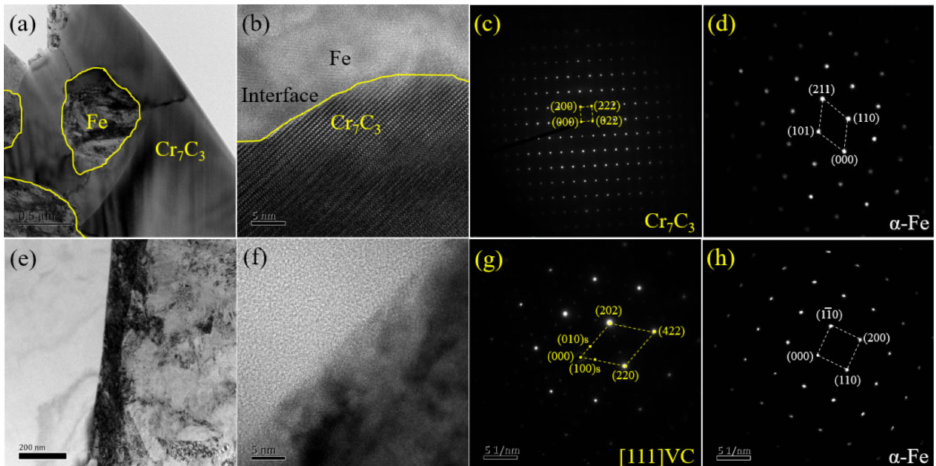
Figure 5. TEM image and electron-diffraction spot in the representative 1.5 Mn sample: ( a ) SEM image of Cr 7 C 3 carbide; ( b ) HR-TEM image of the interface between α -Fe and Cr 7 C 3 carbide; ( c ) ED of Cr 7 C 3 ; and ( d ) ED of α -Fe. ( e ) SEM image and ( f ) HR-TEM image in the interface between α -Fe and VC; ( g ) ED of VC in the [111] zone; and ( h ) ED of α